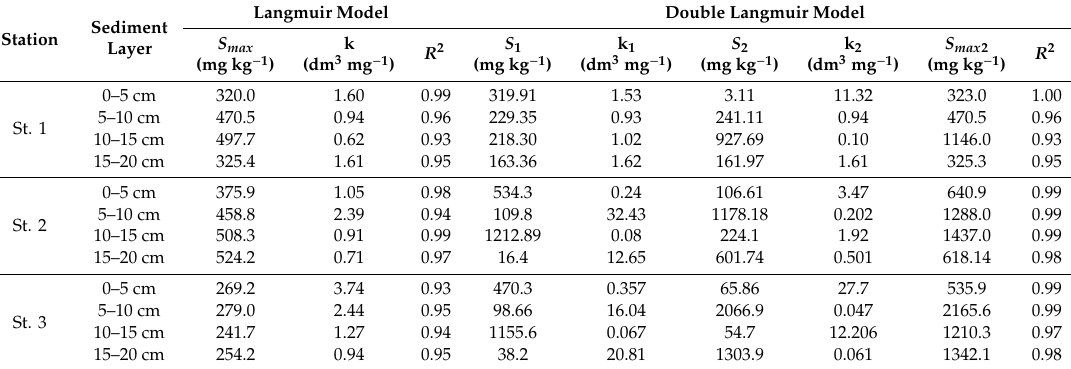
Figure 4. The P adsorption isotherms for sediment taken at St. 3. Table 1. The assessed values of Langmuir sorption model characteristics for profundal bottom sediment of Długie Lake.